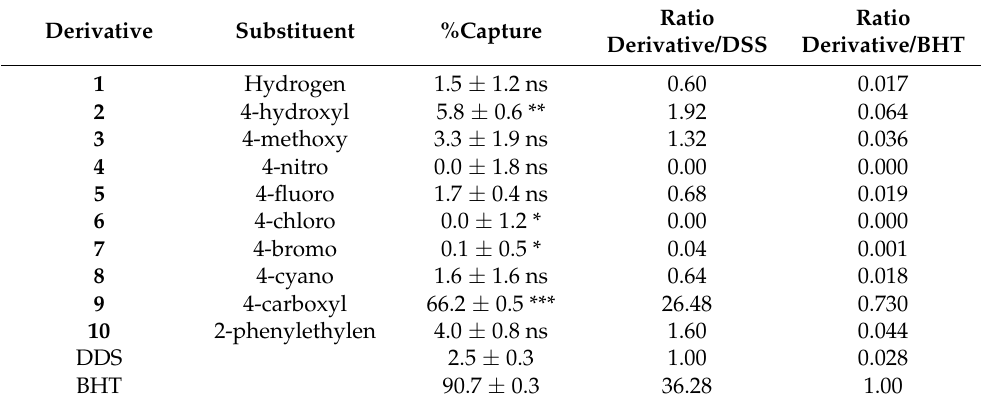
Table 2. Percentage of DPPH radical capturing and correlation ratios against DDS and BHT. Derivative